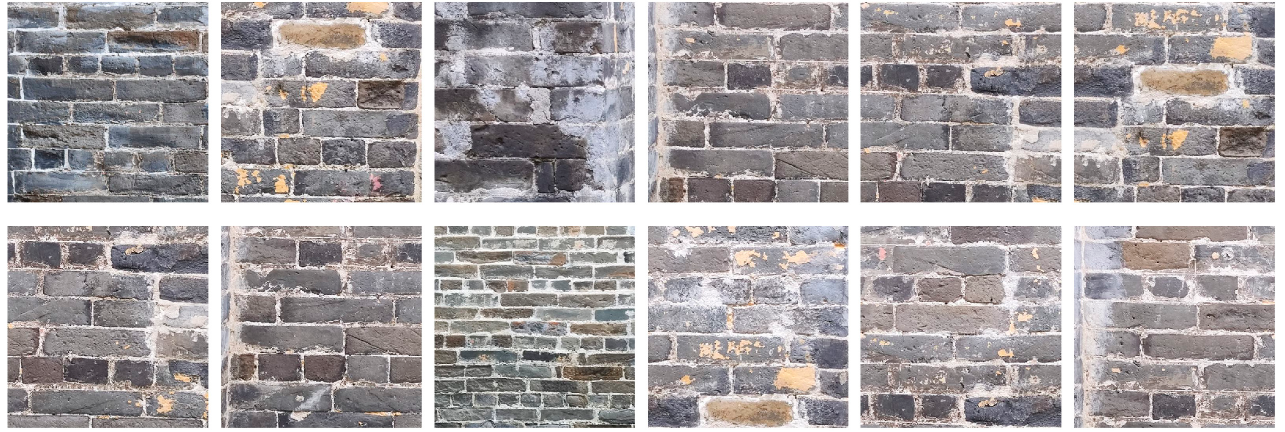
Figure 5. Some photos of gray bricks. (Image Source: photographed by the